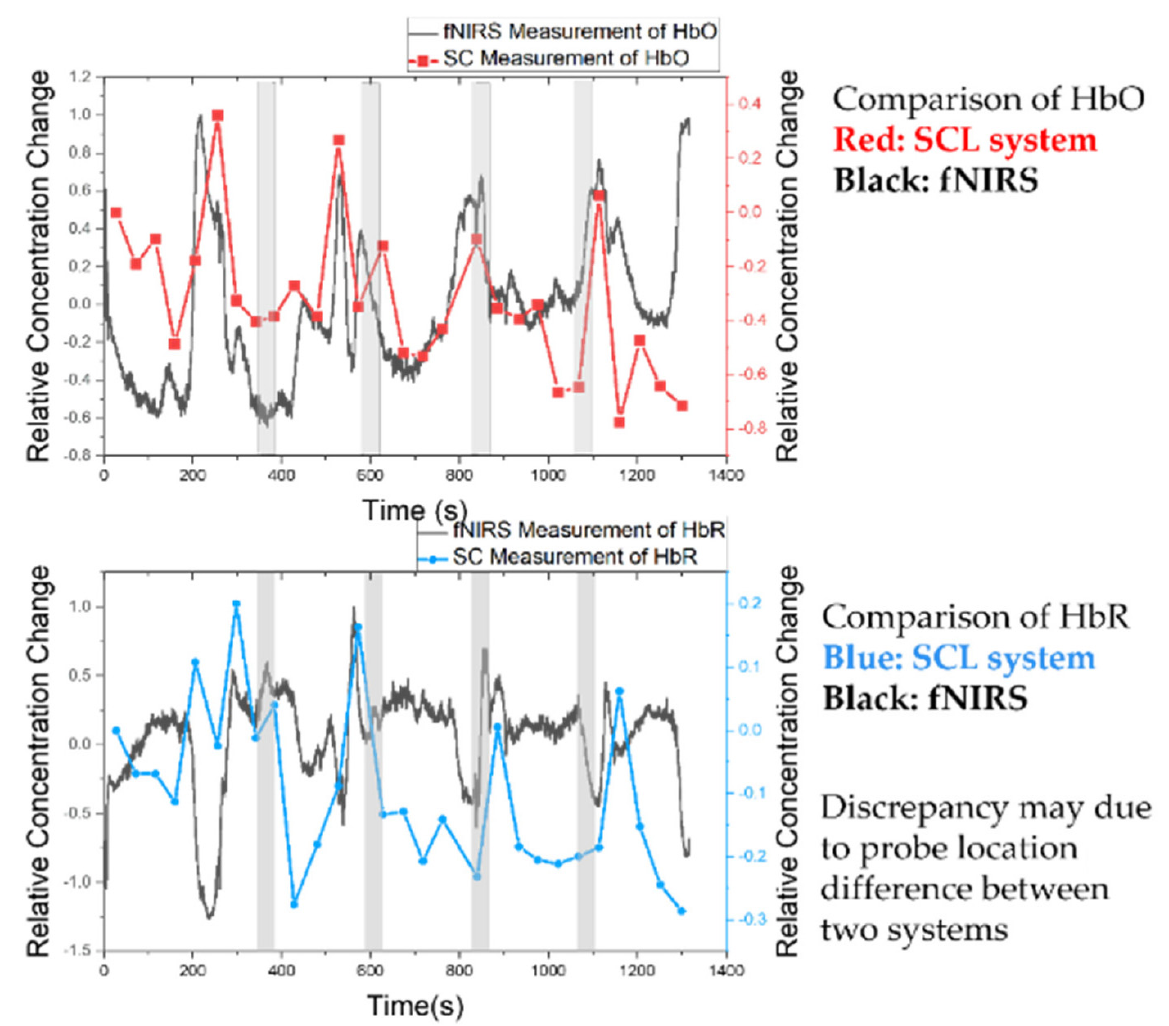
Figure 10. Comparison of HbO and HbR measured with fNIRS and SCISCCO systems.